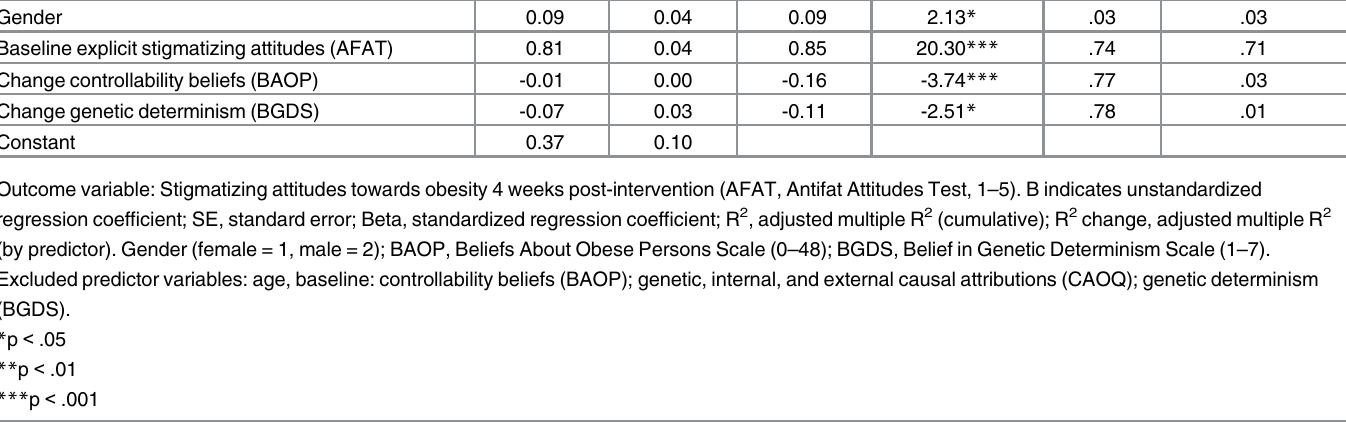
Table 3. Study 2: Multiple linear regression analysis: Prediction of explicit stigmatizing attitudes towards obesity (N = 128).